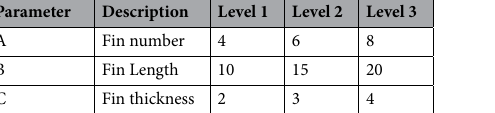
Table 3. Geometry parameters of fins arrangement for microchanel and defined levels.